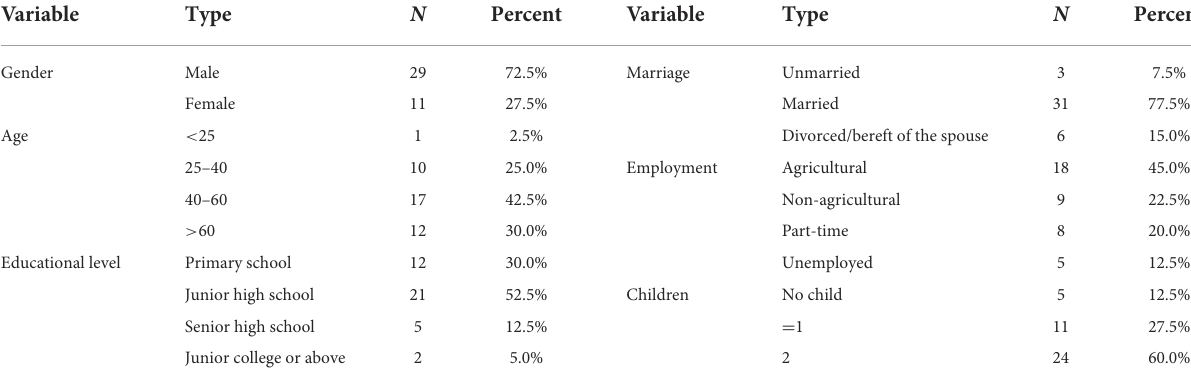
TABLE 2 Demographic characteristics of respondents ( N = 40). Variable